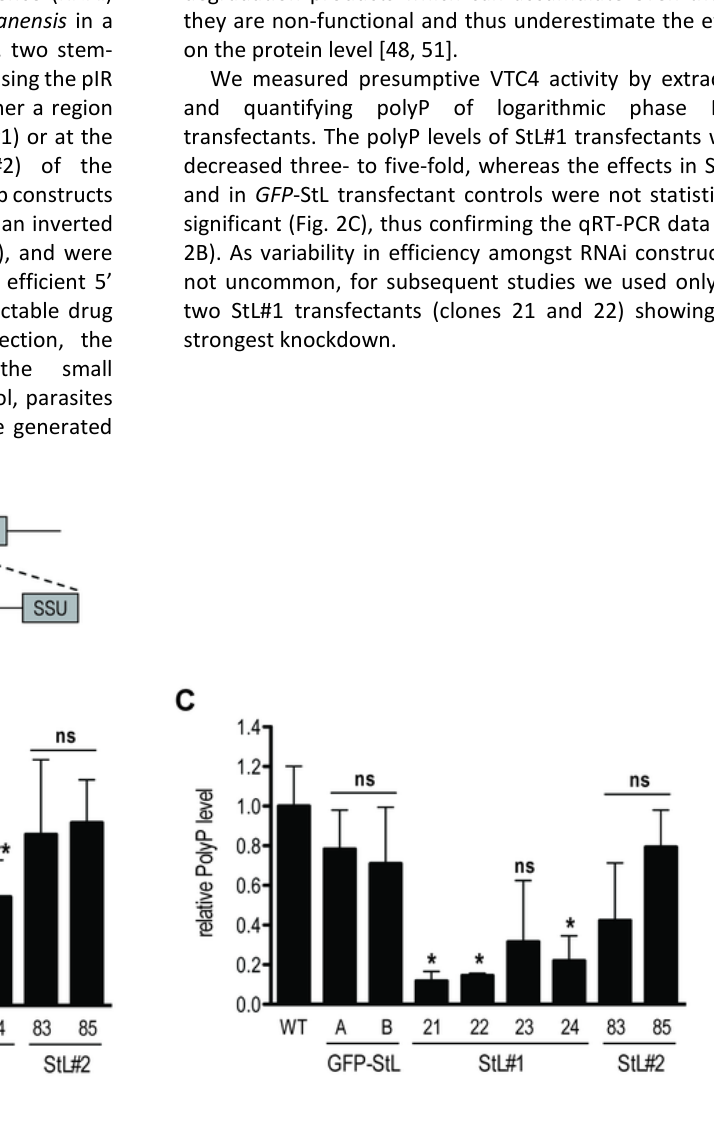
FIGURE 2: RNA interference on VTC4 in L. guyanensis . (A) Schematic map of SSU rRNA locus in Leishmania and targeting of VTC4 . Regions are the SSU rRNA (grey box), VTC4 region (black arrow), puromycin-resistance gene ORF ( PAC , white arrow) and the stem loop stuffer fragment (striped box). (B) Relative VTC4 mRNA levels were assessed by qRT-PCR with VTC4 and KMP11 gene primers. Primer sequences are presented in Table S2. (C) Relative polyP was quantified by digesting the extracted polyP and measuring the released Pi colorimetrically. A and B; 21, 22, 23 and 24; 83 and 85 represented recombinant Leishmania clones selected by antibiotic resistances, for more detail see Fig. S2. Results of a pool of 3 independent experiments were expressed as mean ± SD. Statistical significance was assessed by Student’s t-test (B and C) ; * p < 0.05, *** p < 0.001, ns: